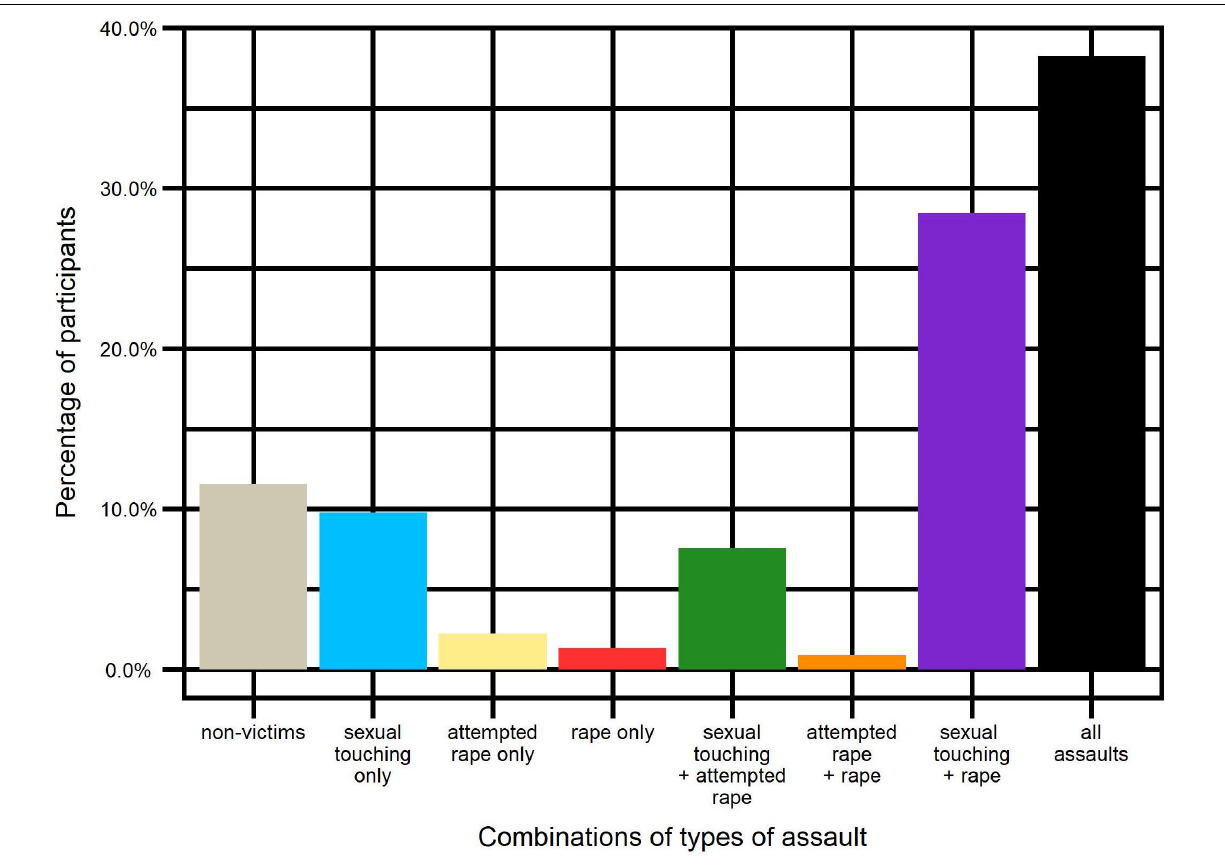
FIGURE 2 | Percentage of participants in combinations of types of